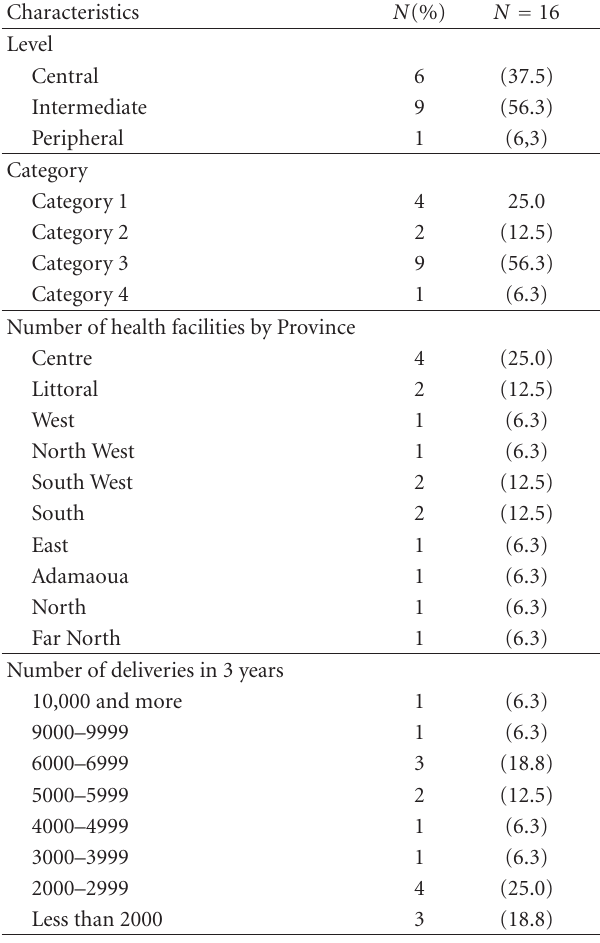
Table 1: Characteristics of health facilities